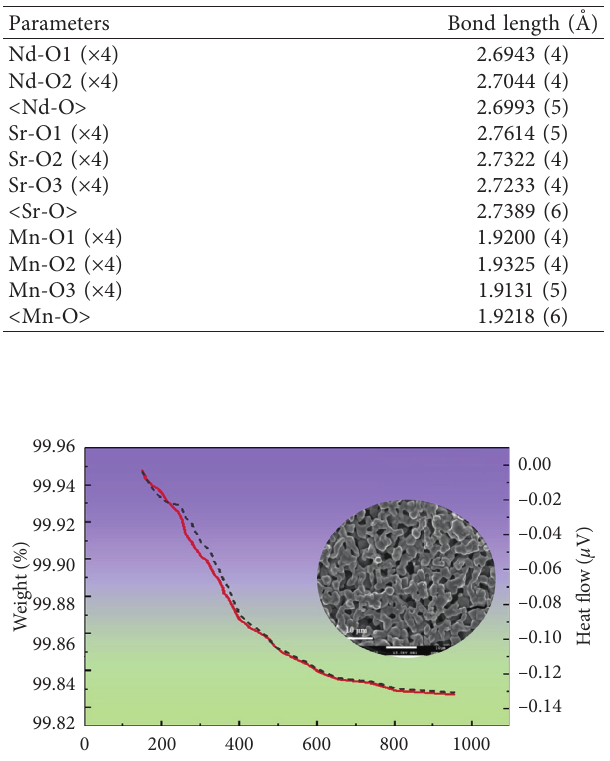
Table 2: List of Wyckoff positions, atomic positions, and isotropic Table 3: Leading bond distances (˚A) ( d ≤ 6 ˚A) for orthorhombic